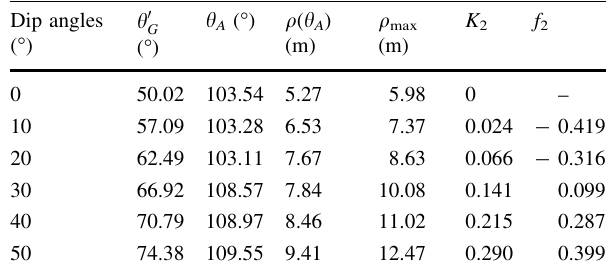
Fig. 13 Variations of drawing body parameters with increasing seam dip angle in the initial drawing stage: a h 0 Table 2 Drawing body parameters for different seam dip angles in the normal drawing